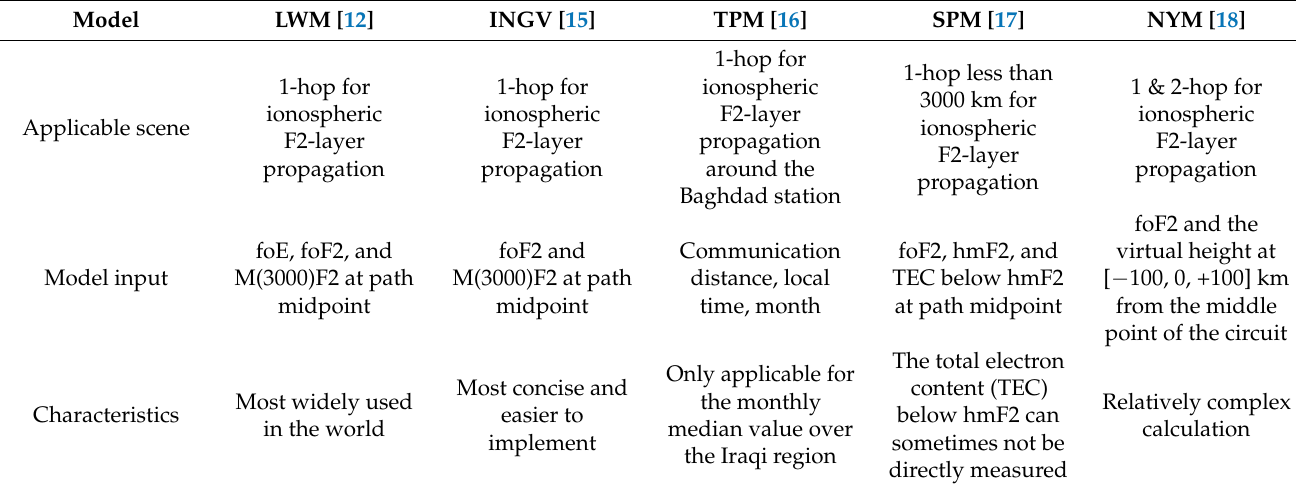
Table 1. The characteristics of the common MUF calculation